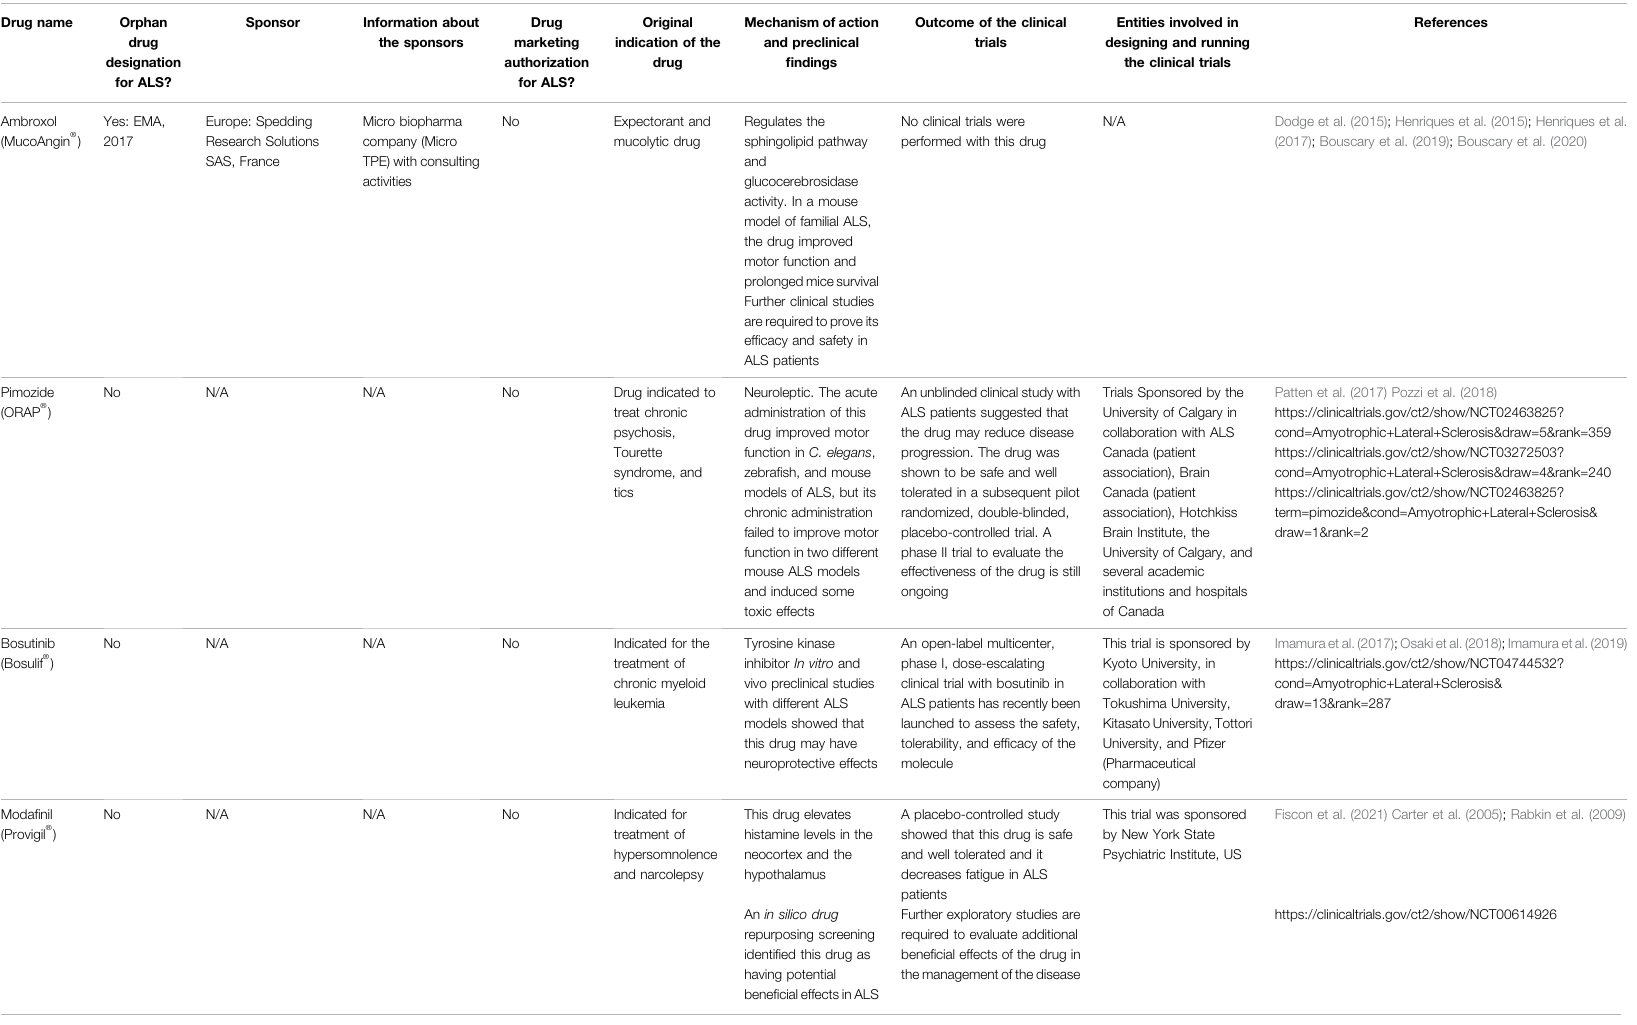
The following websites were consulted to build up this table. Community Register of orphan medicinal products from the European commission: https://ec.europa.eu/health/documents/community-register/html/reg_od_act.htm?sort (cid:1) a.. Orphan Drug Designations and Approvals from the FDA: https://www.accessdata.fda.gov/scripts/opdlisting/oopd/.ClinicalTrial.gov to retrieve the list of clinical trials for ALS: https://clinicaltrials.gov/ct2/results? cond (cid:1) Amyotrophic+Lateral+Sclerosis&term (cid:1) &cntry (cid:1) &state (cid:1) &city (cid:1) &dist (cid:1)